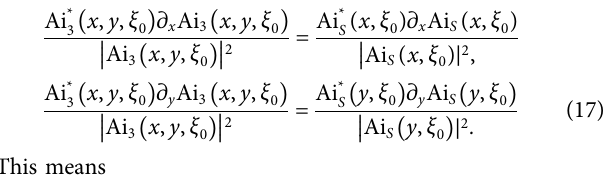
FIGURE3| Shadedcontourplotsofthetransversephasegradient 14.063. Positive regions are superoscillatory, while negative ones are not. Solid white and dashed black lines are, respectively, the projections of the parabola and de fi ning